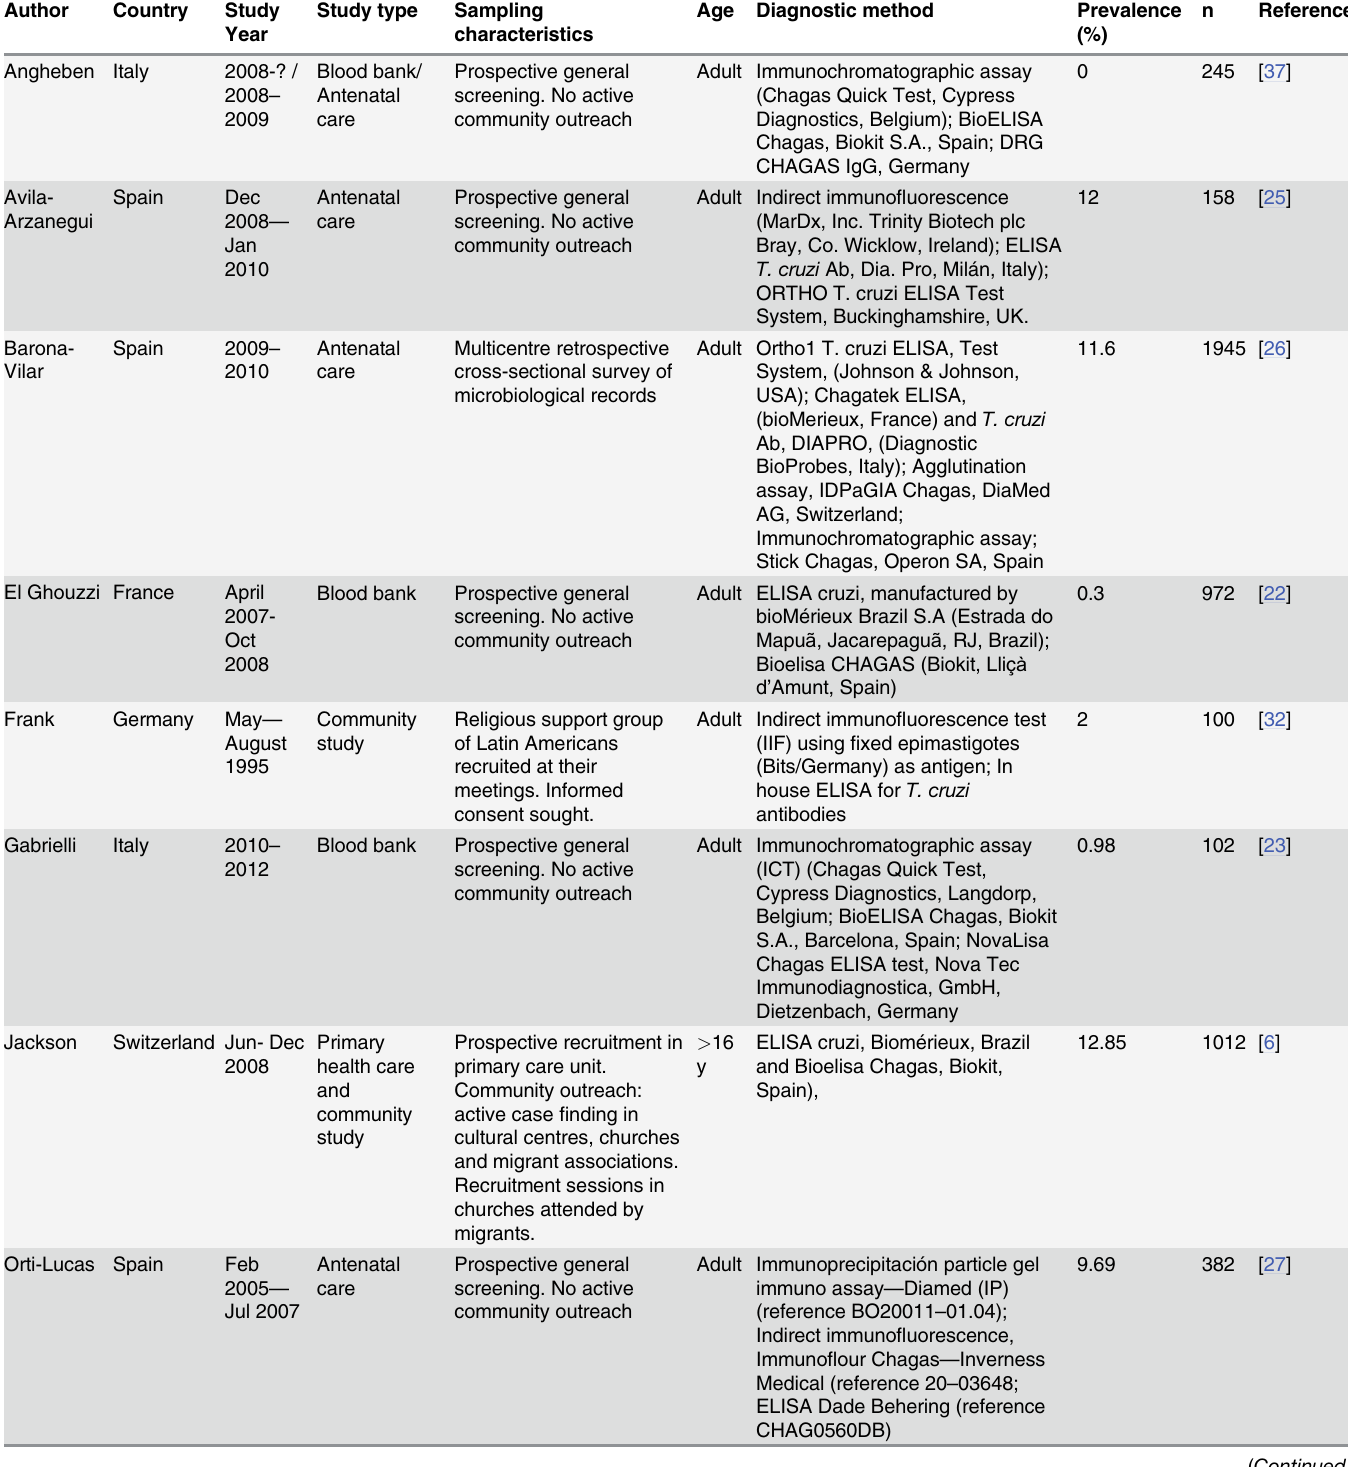
Table 1. Main characteristics of the studies included in the